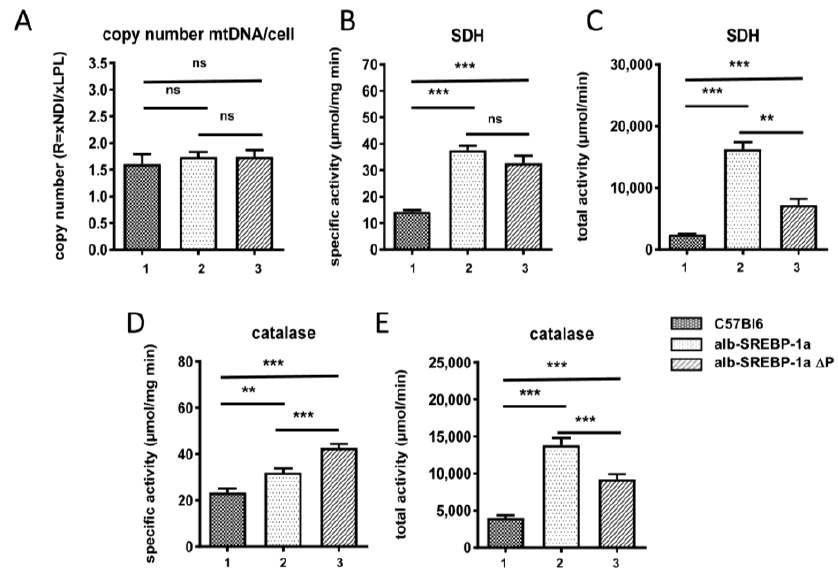
Figure 2. Mitochondria and Peroxisomes in (1) C57Bl6, (2) alb-SREBP-1a and (3) alb-SREBP-1a∆P mice. ( A ) The mitochondrial DNA content was determined in comparison to genomic DNA in C57Bl6, alb-SREBP-1a and alb-SREBP-1a∆P mice ( n = 15). Mitochondrial SDH activities (specific ( B ), total ( C )) and specific ( D ) and total ( E ) peroxisomal catalase activity were determined in liver homogenates of C57Bl6, alb-SREBP-1a and alb-SREBP-1a∆P mice ( n = 15). Data are expressed as mean ± SD ( n = 8 of each phenotype). * p < 0.05, ** p < 0.01 *** p < 0.001 by Student’s t test. Abbreviations are: mtDNA, mitochondrial DNA; SDH, succinate dehydrogenase.